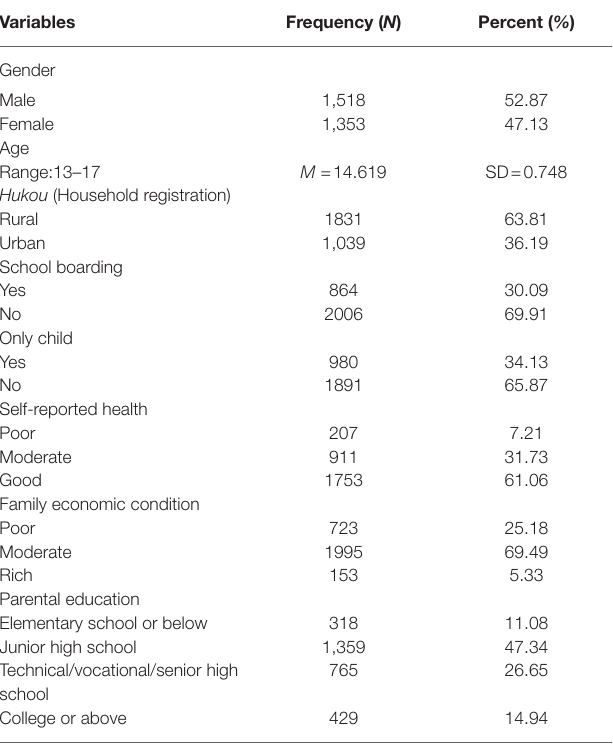
TABLE 1 | Demographic characteristics of the participants ( n =